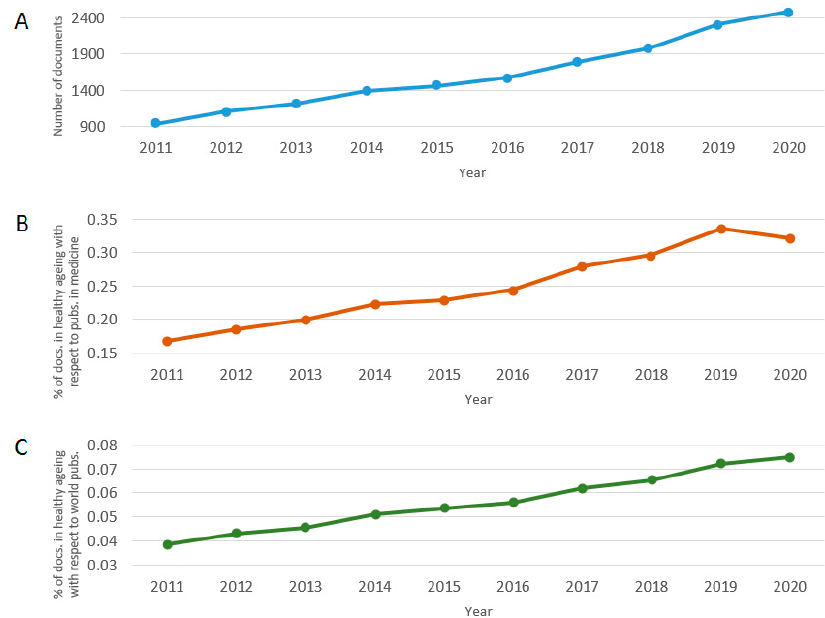
Figure 1. ( A ) Number of documents published per year on the topic of “healthy aging” according to the Scopus database and the percentage of documents on healthy aging with respect to ( B ) the total number of documents published in the “Medicine” area in the world and ( C ) the total number of documents published in the world during the period of 2011–2020.